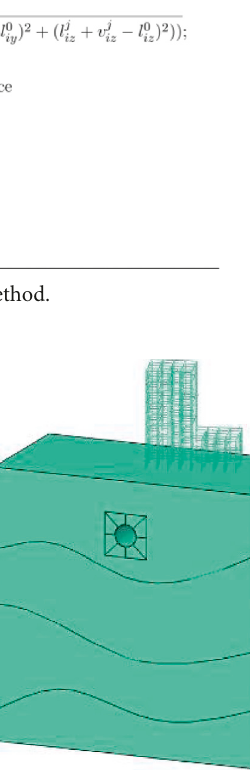
Figure 7: Schematic diagram of finite element